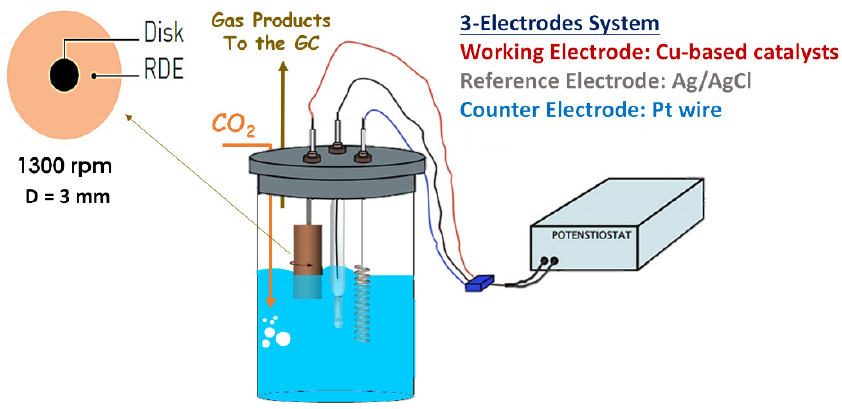
Figure 2. Simplified conceptual scheme of the CO 2 electrochemical reduction setup.